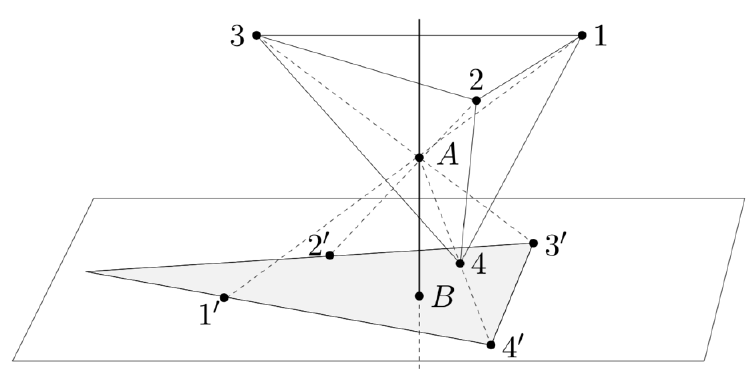
Figure 3 . Projection through A at four